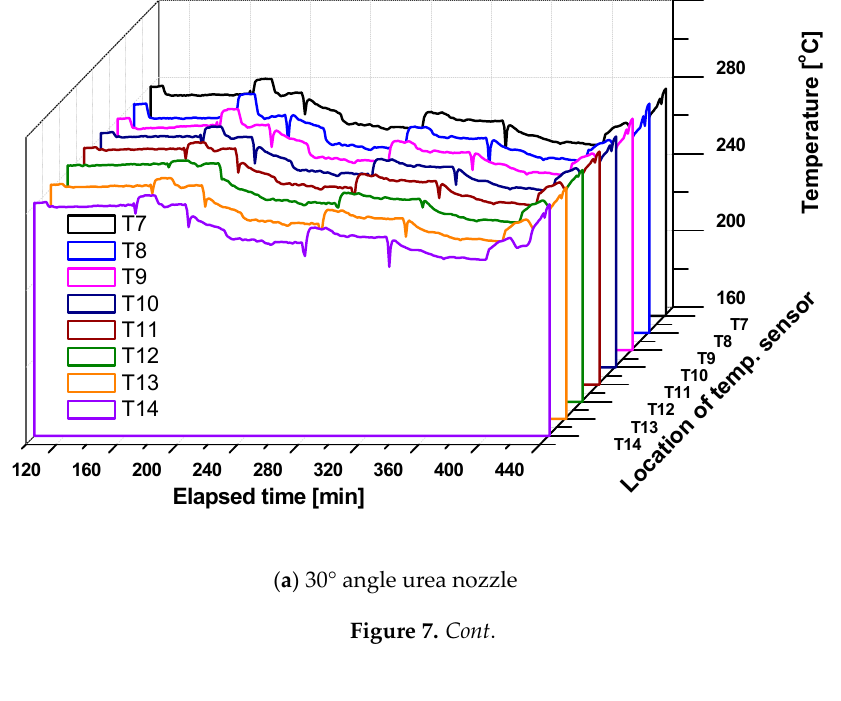
Figure 6. Characteristics of NOx reduction rate in relation to the spray angle of the urea nozzle tip.